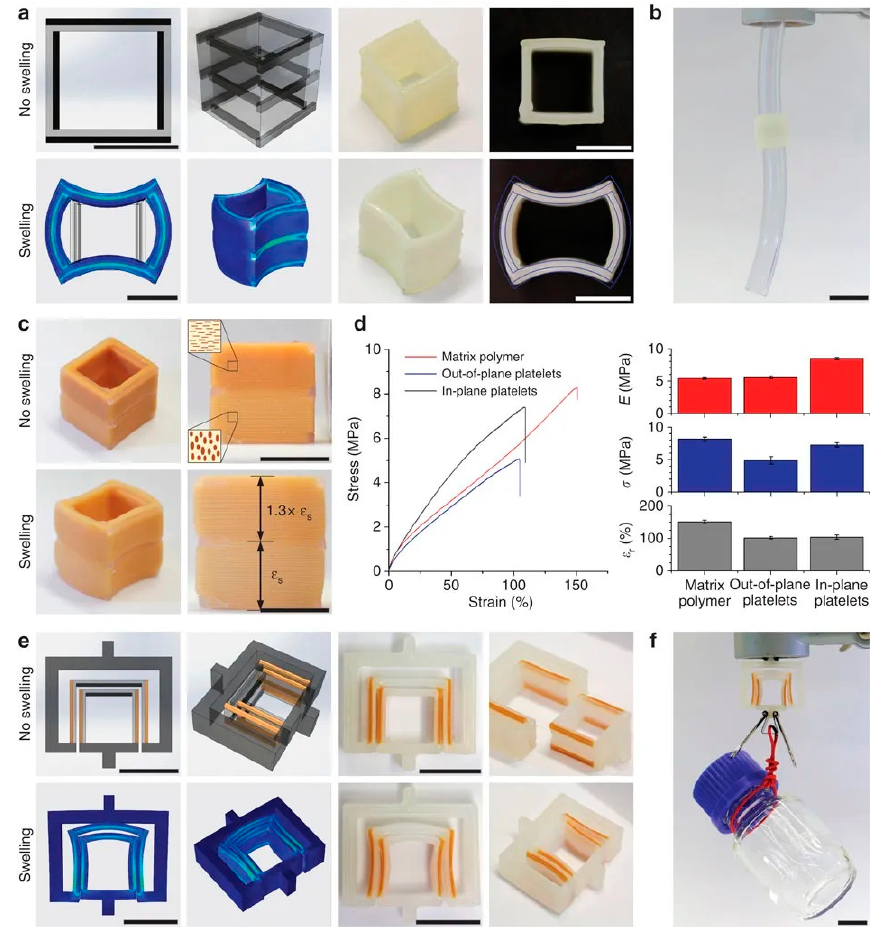
Figure 11. Soft mechanical fasteners fabricated through the programmable MM-3D printing of shape-changing objects. ( a ; Top) Drawings and actual printed cuboids before the shape change. This part is named cuboid 1. ( a ; Bottom) Finite element simulations and actual pictures of the cuboids after the shape change. At the bottom right, the simulated cross-section of the cuboid is superimposed on a picture of the actual part to illustrate the good agreement between experimental and predicted curvatures. Scale bars, 10 mm. ( b ) Cuboid-mediated fastening of two tubes achieved through the shape change of the printed object. Scale bar, 20 mm. ( c ) Cuboid object with same architecture as in a but containing anisotropic platelets magnetically aligned in different orientations within the soft phase. This part is named cuboid 2. The platelets are aligned horizontally in the top, darker half and vertically in the bottom, brighter half. Scale bar, 10mm. ε s is the swelling strain. ( d , Left) Representative stress–strain curves of printed materials comprising the soft phase reinforced with platelets aligned in different orientations. ( d , Right) Elastic modulus ( E ), strength ( σ ) and strain-at-rupture ( ε r ) of the printed materials with different textures. Error bars show s.d. (n = 5). ( e , Top) Drawings and actual printed key–lock objects before the shape change. ( e ; Bottom) Finite element simulations and actual pictures of the key–lock structure after the shape change. Scale bars, 15 mm. ( f ) Mechanical fastening enabled by the shape changing key–lock architecture. Scale bar, 15 mm. In all drawings, light and dark grey colours indicate soft and hard phases, respectively. Reprinted from [39], © 2015, with permission from Springer Nature.